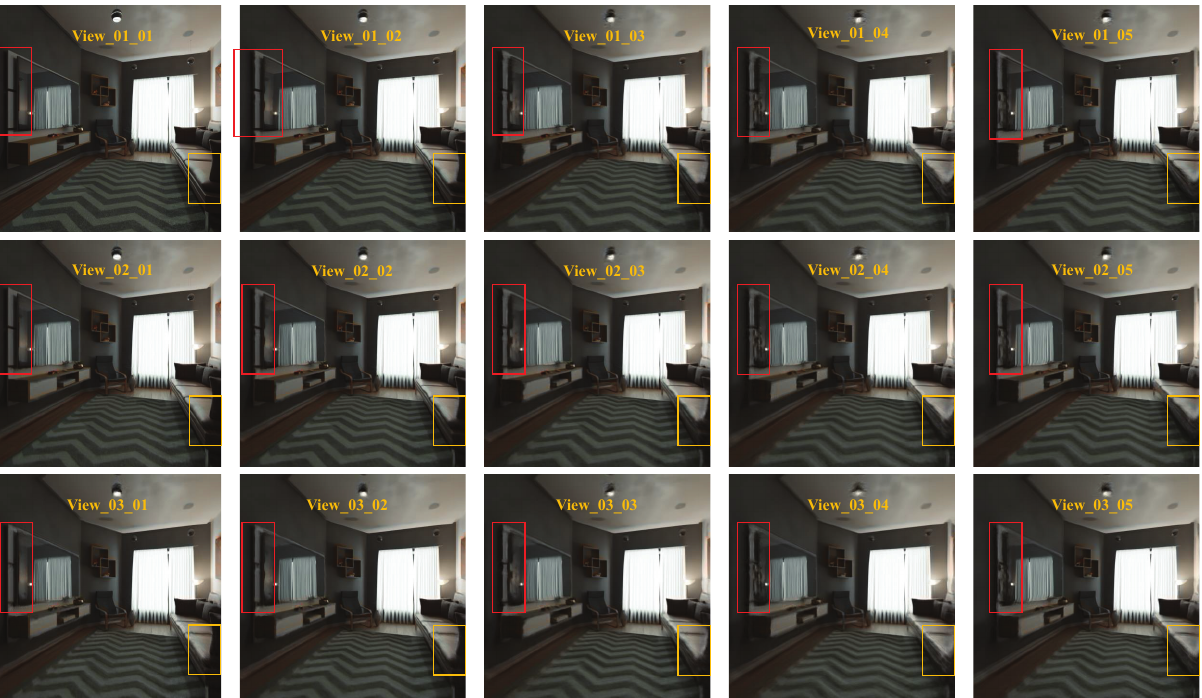
Figure 7. Results of light fields angular super-resolution on our